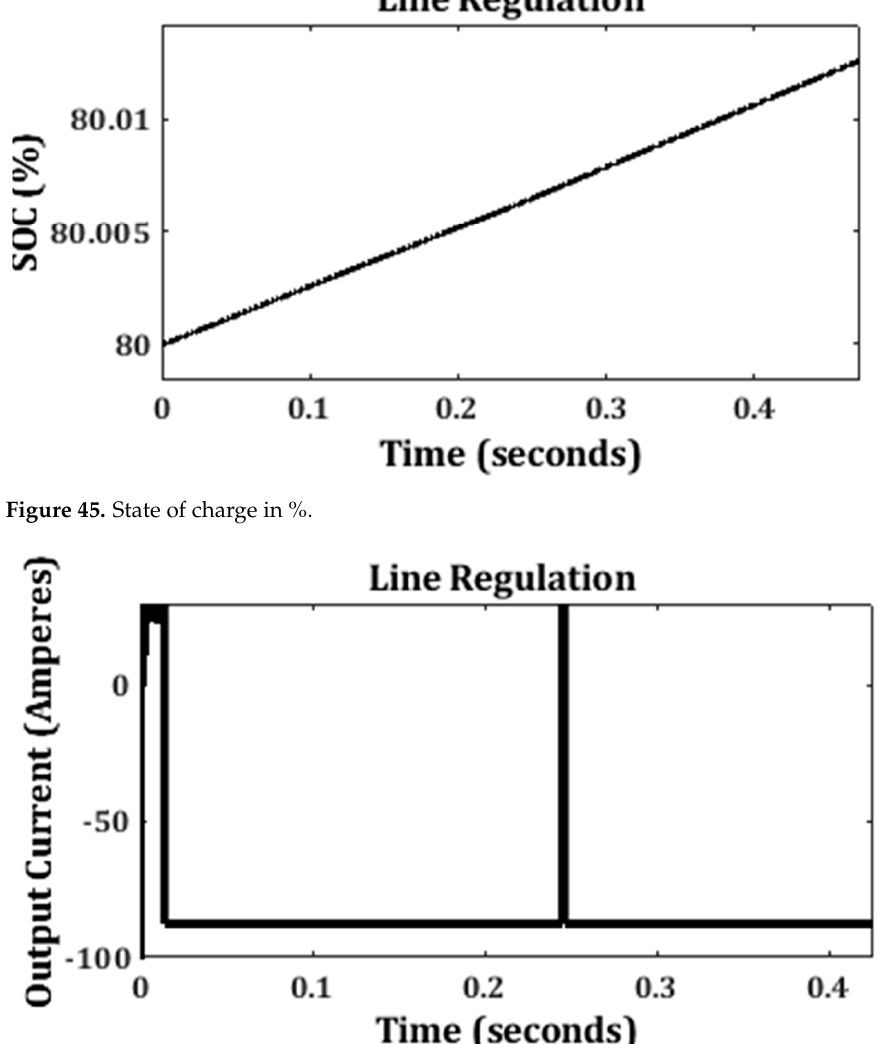
Figure 46. Battery current in Amperes during the line